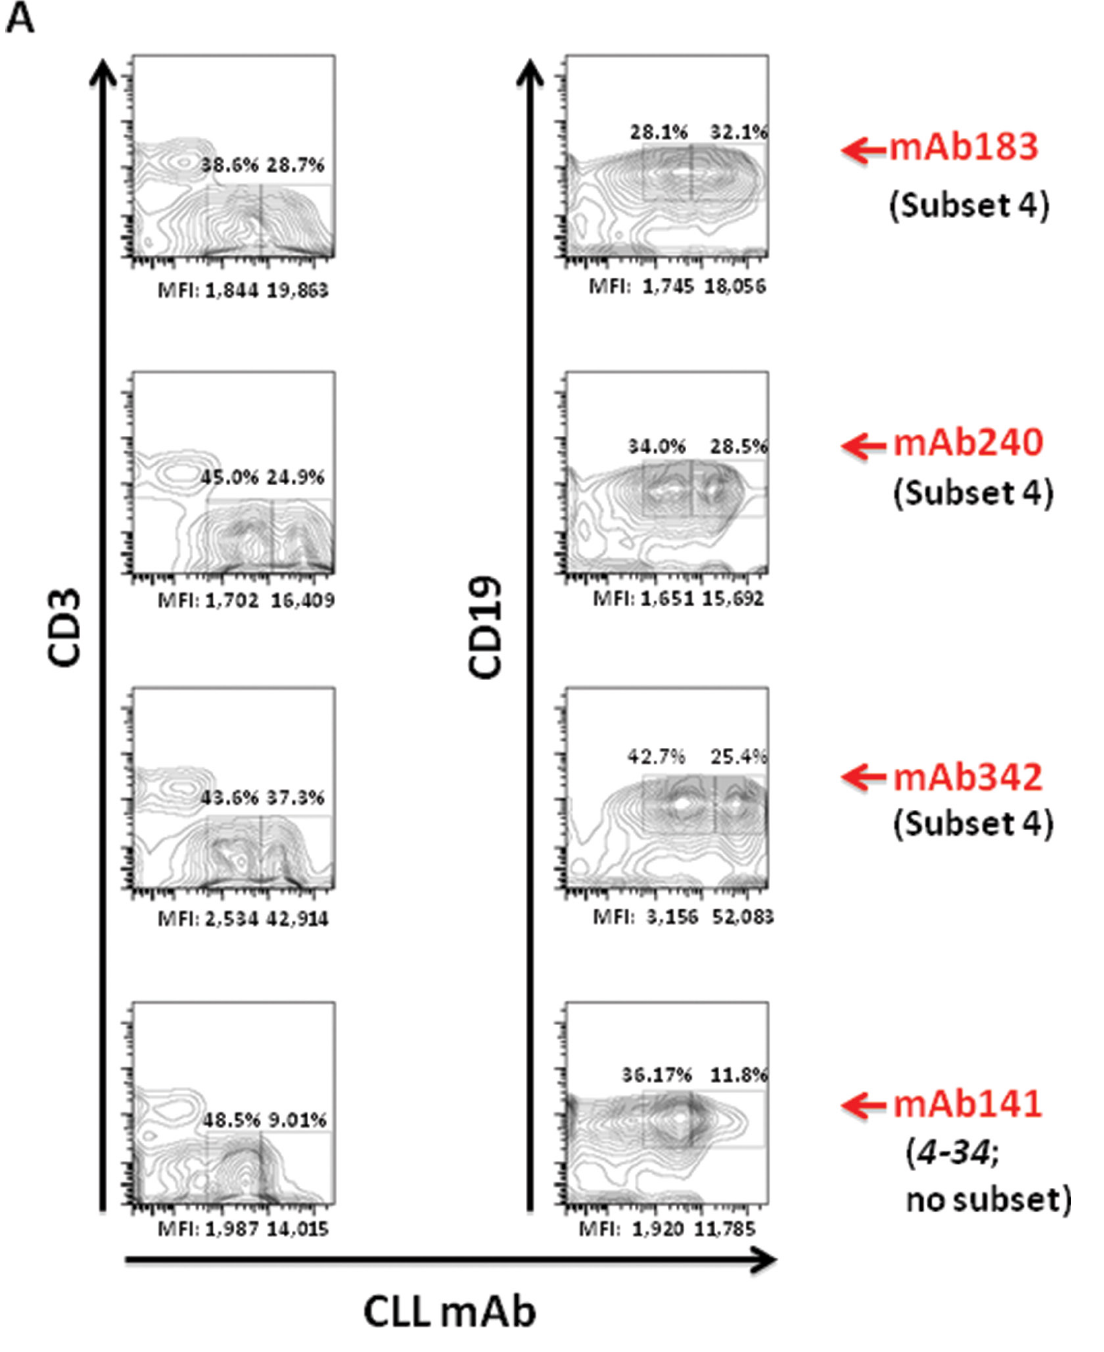
Figure 2. CLL IGs belonging to subset 4 bind with different intensities to memory and naïve B cells. Tonsil mononuclear cells were in- cubated with CLL subset 4 mAbs 183, 240 and 342, and with a panel of commercial antibodies reactive with membrane antigens that distinguish human B cell subsets. (A) Two subpopulations (dim and bright) of CD19 + cells can be identified based on CLL subset 4 mAb binding. mAb141, which uses IGHV4-34 but does not belong to subset 4, recognizes only one population. (B) After gating specifically on CD19 + cells, it is clear that the CD19 + /CLL mAb bright fraction is predominantly CD27 – /IgD + /CD38 l ° w (naïve B cells) and the CD19 + /CLL mAb dim cells are mainly CD27 + /IgD – /CD38 l ° w/high (memory B cells). In contrast, CD19 + cells bound by mAb141 are predominantly CD27 – /IgD + /CD38 l ° w cells (naïve B